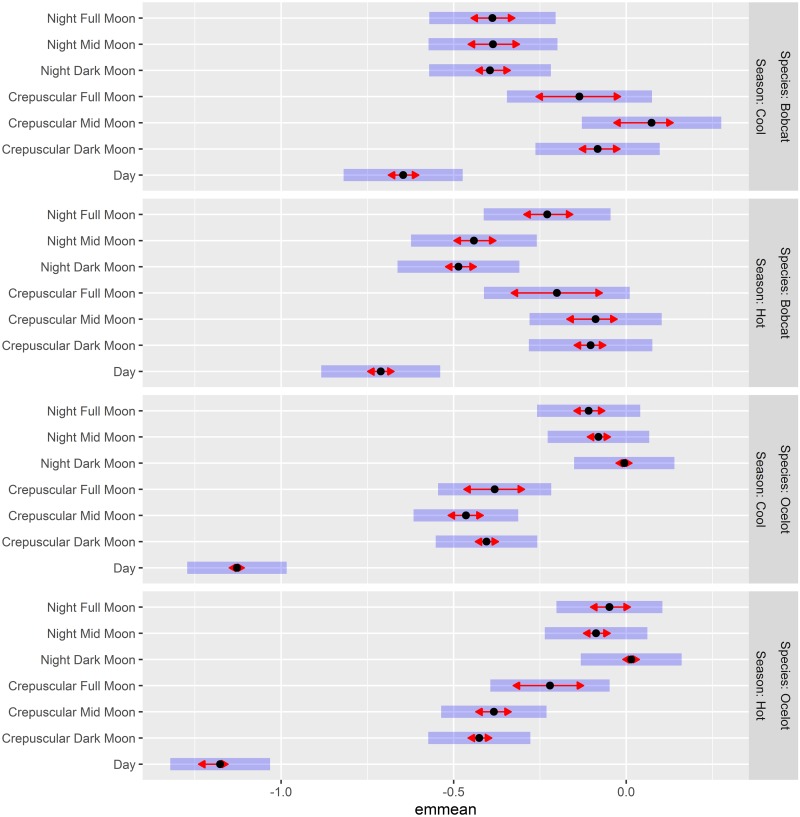
Pairwise comparisons of ocelot and bobcat log Velocity for combinations of season, lunar illumination, and diel period.Estimated marginal means (emmeans) displaying predicted log Velocity of ocelots and bobcats trapped on the East Foundation’s El Sauz Ranch between 2013 and 2017. Estimated marginal means are grouped according to Season and Species, with all combinations of diel period and lunar illumination displayed within each grouping. Estimated marginal means are displayed as black dots, with 95% confidence intervals represented by the purple bars. Red arrows allow statistical comparisons between groups of interest. Non-overlapping arrows are indicative of movement rates that are significantly different (α = 0.05) from each other.